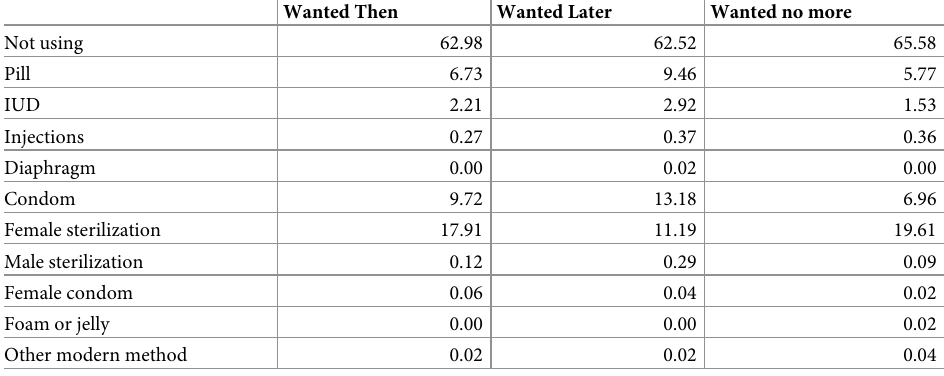
Table 2. Percentage of contraceptive use within one year after having recent birth by woman’s pregnancy inten- tion, India, NFHS-2015-2016. Wanted